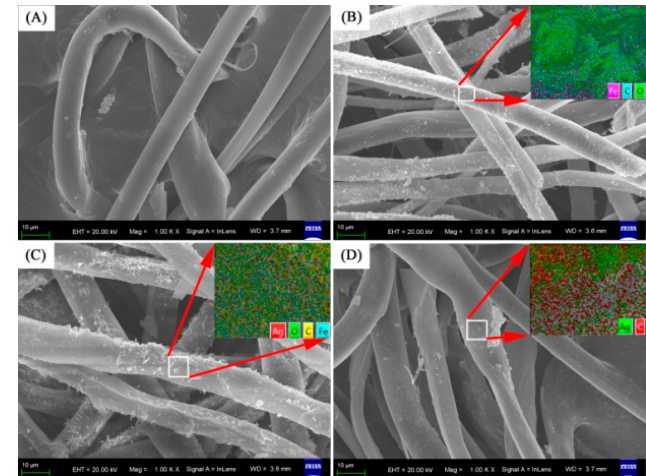
Figure 1. Cont. Figure 1.